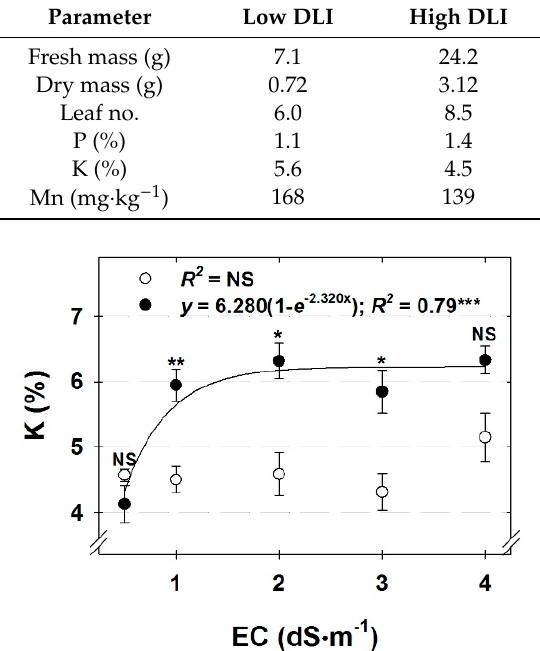
Table 5. Fresh and dry mass, leaf number, and P, K, and Mn tissue concentrations of dill ( Anethum graveolens ‘Fernleaf’) 4 weeks after transplanting into nutrient-film technique hydroponic systems in a greenhouse under a low (~7 mol·m − 2 ·d − 1 ) or high (~18 mol·m − 2 ·d − 1 ) daily light integral (DLI) with a range of nutrient solution electrical conductivity (EC; 0.5 to 4.0 dS·m − 1 ) treatments. Data were pooled across EC within DLI for each species. Each value represents the mean of three replications.